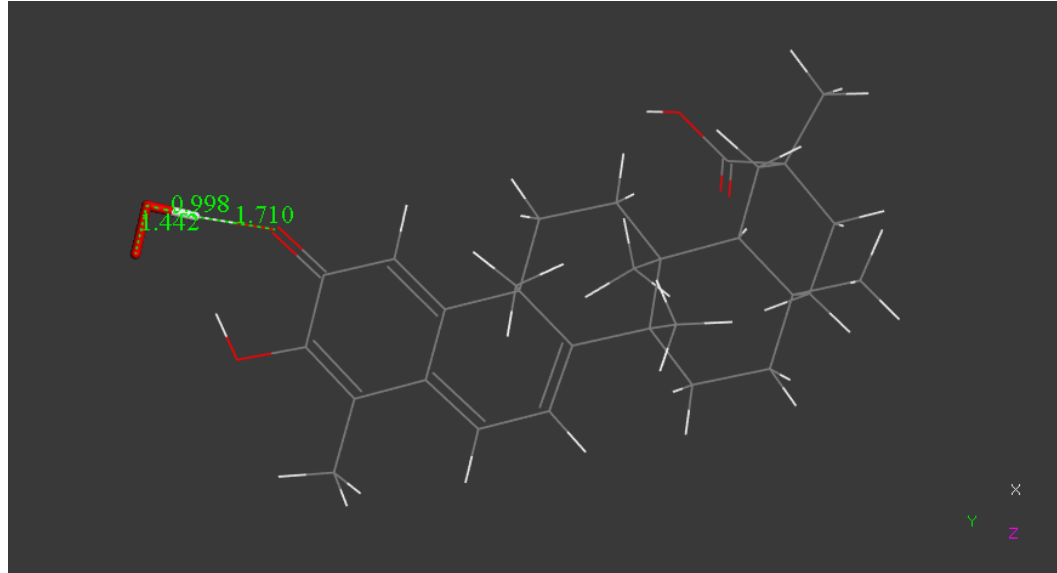
Figure 11. From Figure 10, the water and the O 2 molecules were eliminated and the remaining species contains a catechol moiety. Hence, a potential approach of another superoxide is able to sequester a H atom, d(O 2 -H) = 0.998 Å, forming the O 2 H species. This is the classical manner of scavenging radicals by polyphenols, (option a ). Total charge is − 1, due to O 2 H. Interestingly, the O 2 H − species in turn can capture a proton to form H 2 O 2 .